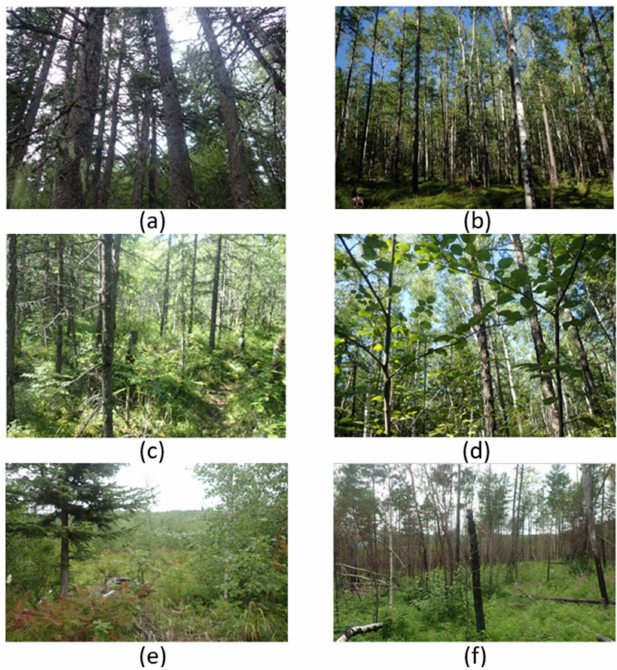
Figure 2. Overview examples of forest plots in the field: ( a ) plot NR1, located below the tundra belt, at 1305 m a.s.l., and dominated by mountain spruce forests; ( b ) plot NR2, located along the trail, at 853 m a.s.l., dominated by larch; ( c ) plot NR3, located at 626 m a.s.l., along the river valley, with the dominant species being larch and spruce in the river valley; ( d ) plot NR4, located near the road, with dominant trees including birch and larch; ( e ) plot BZ1 buffer zone plot, which experienced both massive forest fire and clearcutting in 2003 and 2007, and is now recovered by grass and shrub and birch; ( f ) plot ONR1, outside reserve plot, experienced with frequent annual burning from wildfires, the latest of which occurred in July. The photos were taken on 8 August 2016 (Khatancharoen 2016; personal